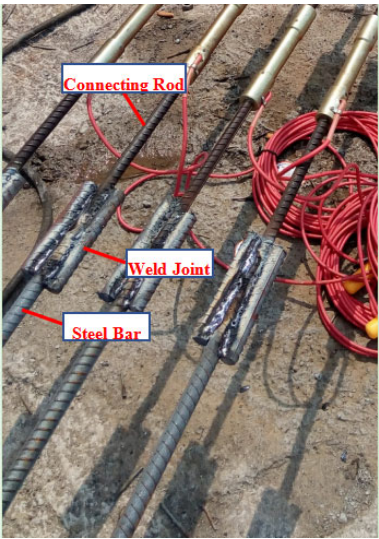
Figure 5. The manufactured testing soil nails.